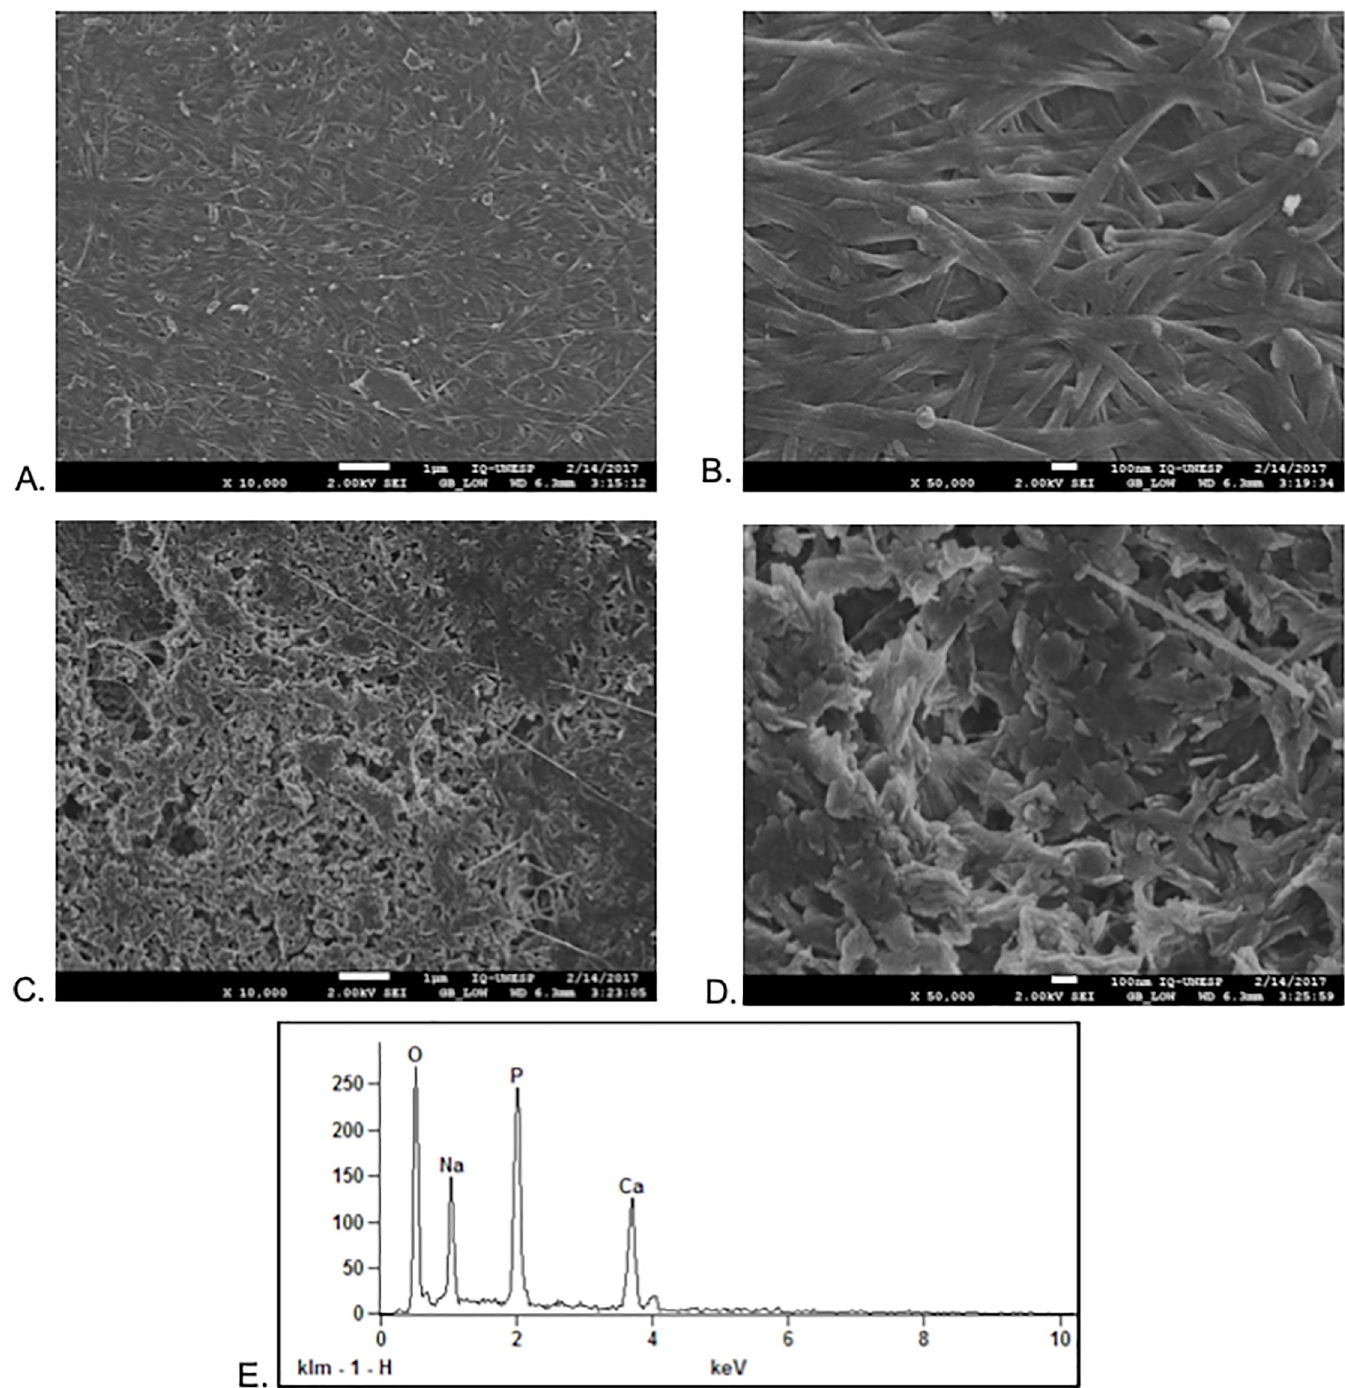
Fig 1. SEM images of the BC and BC-HA membranes. (a) and (b) BC surface at 10,000X and 50,000X, respectively; (c) and (d) BC-HA surface at 10,000X and 50,000X, respectively. Acceleration voltage was 2kV for these samples. (e). EDS spectrum from a typical membrane with surrounding HA crystals.